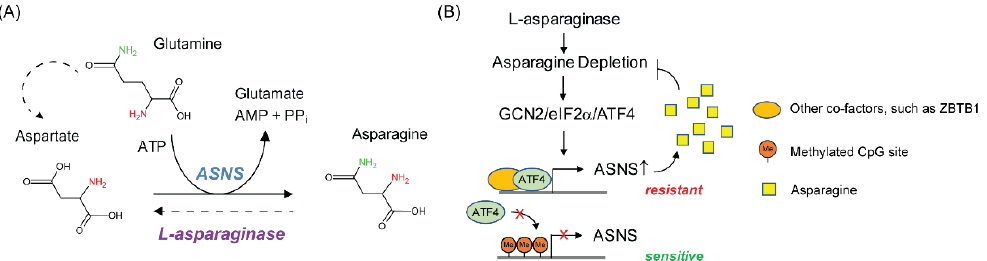
Figure 1. Asparagine de novo biosynthesis in driving L-asparaginase resistance. ( A ) ASNS catalyzes asparagine biosynthesis by using glutamine, aspartate and ATP. In proliferating mammalian cells, most aspartate is synthesized de novo by using oxaloacetate and glutamate as substrates. Since glutamate is produced through glutamine deamination, which can be further deaminated to fuel the TCA cycle to generate oxaloacetate, glutamine is the major carbon and nitrogen donor for aspartate biosynthesis [56]. Catabolism of asparagine to aspartate by L-asparaginase has not been reported in mammalian cells. ( B ) Asparagine depletion by L-asparaginase activates GCN2 pathway, leading to ATF4 accumulation, which turns on ASNS. As a result, cells synthesize more asparagine to mitigate the stress. However, ATF4 cannot be recruited to the ASNS promoter unless it is